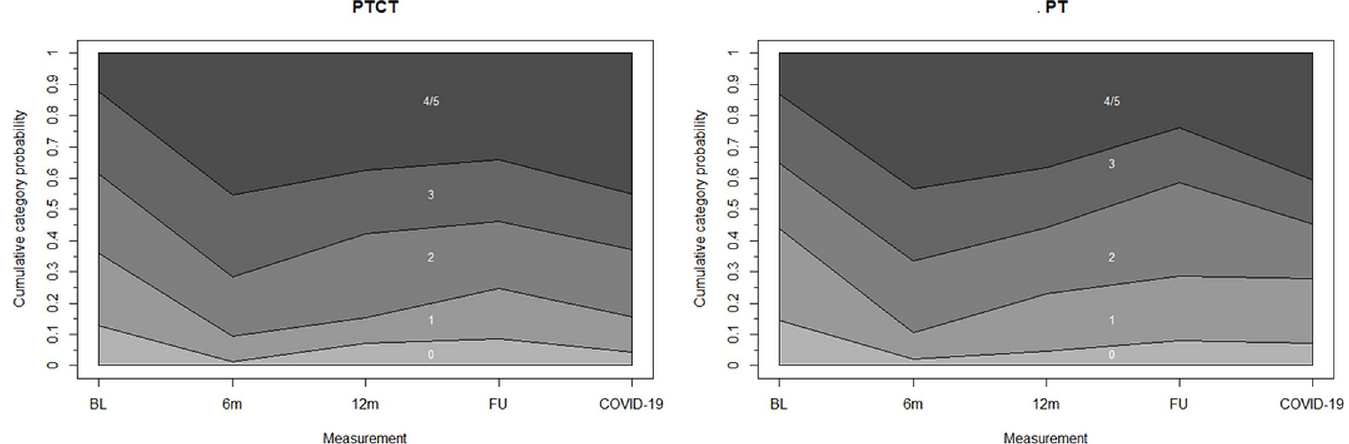
Fig 4. Physical activity category selection probability by study group from the multinomial logistic longitudinal path model. Physical activity categories: 0 = No more than necessary; 1 = Casual walks/light outdoor recreation 1–2 times a week; 2 = Casual walks/light outdoor recreation several times a week; 3 = Brisk physical activity 1–2 times a week; 4/5 = Brisk physical activity or keep fit exercise several times a week. BL = baseline; 6m = six months; 12m = twelve months; FU = one year post-intervention